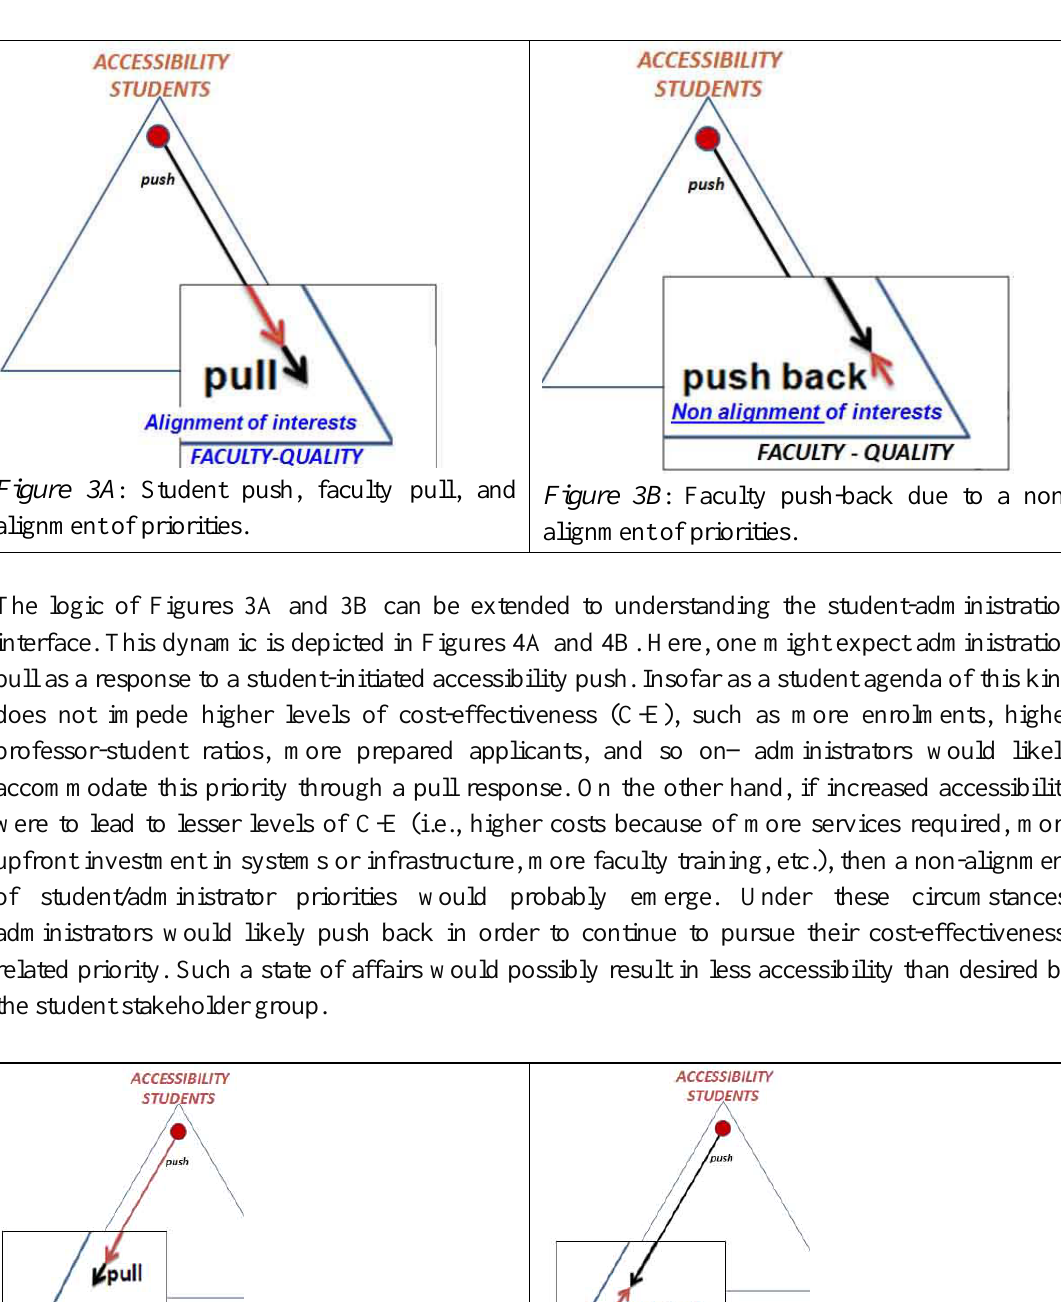
Figure 4B : administrator push-back due to a non-alignment of